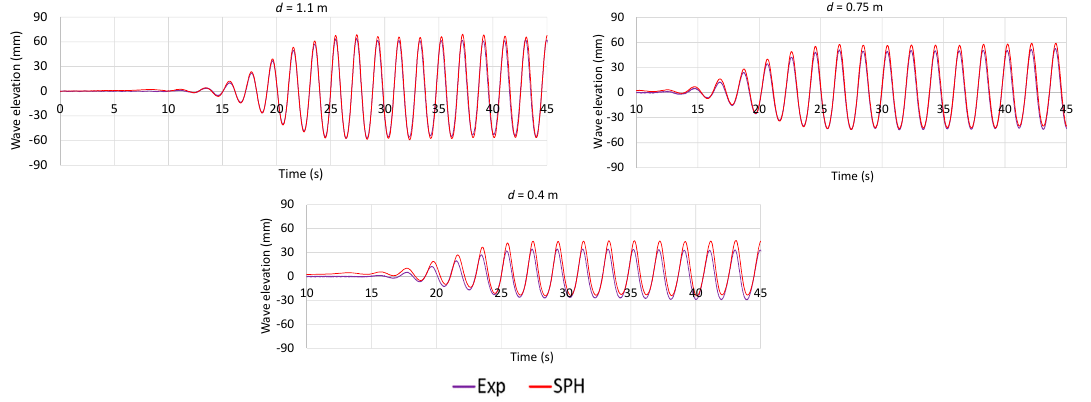
Figure 11. Comparison of wave elevation for A = 50.5 mm and T = 1.95 s with three water depths.